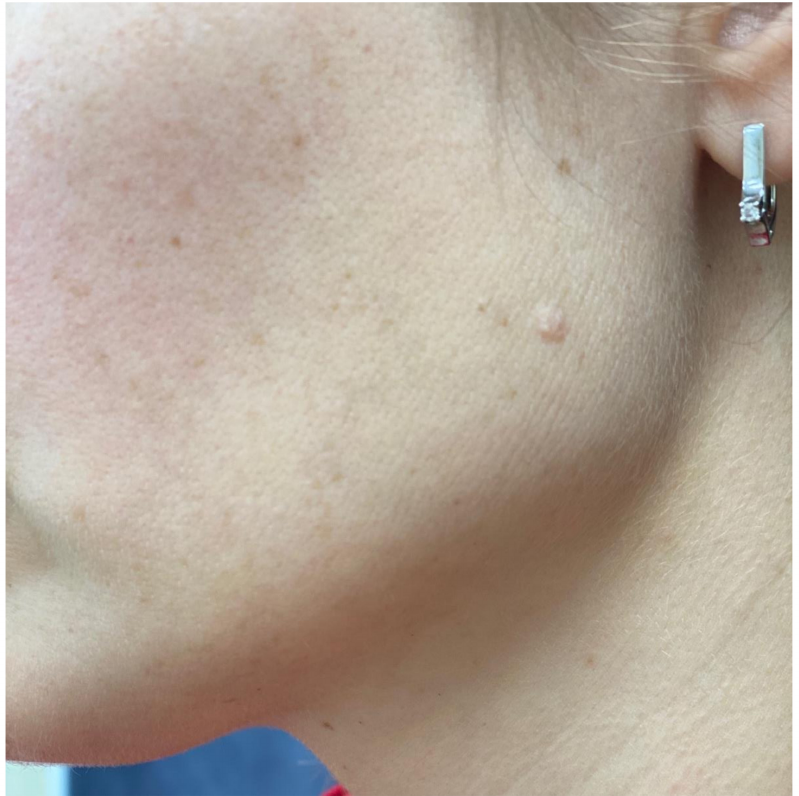
Figure 5. The scar after removal of a neoplasm on the skin of the face after 10 years.